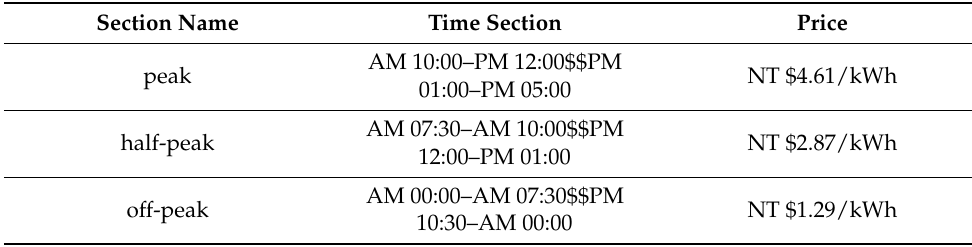
Table 4. The price of the three-stage electricity pricing model.